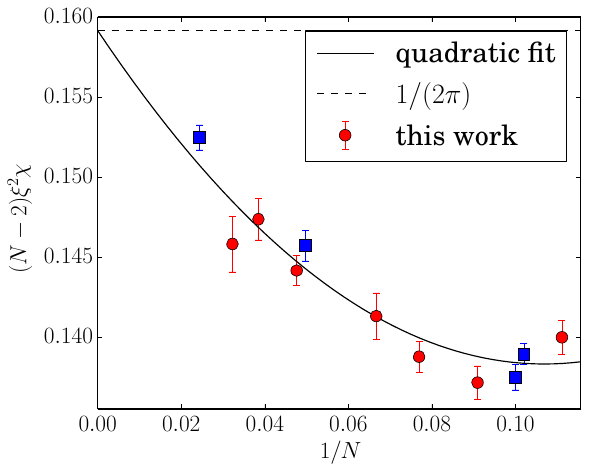
Figure 9 . Fit to the large- N behavior of the topological susceptibility, using the N eq. (4.8).